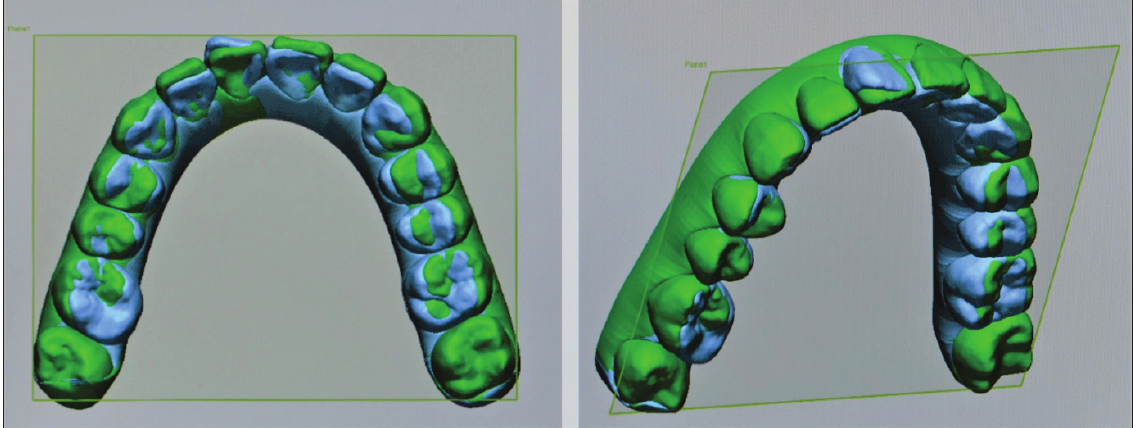
Figure 5. The best fit superimposition with a common transverse reference plane for both pretreatment and predicted post-treatment STL files.